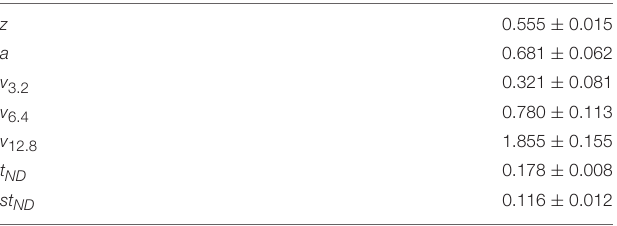
TABLE 1 | Fitted parameters (mean ± SE) of the pure DDM (model p ).